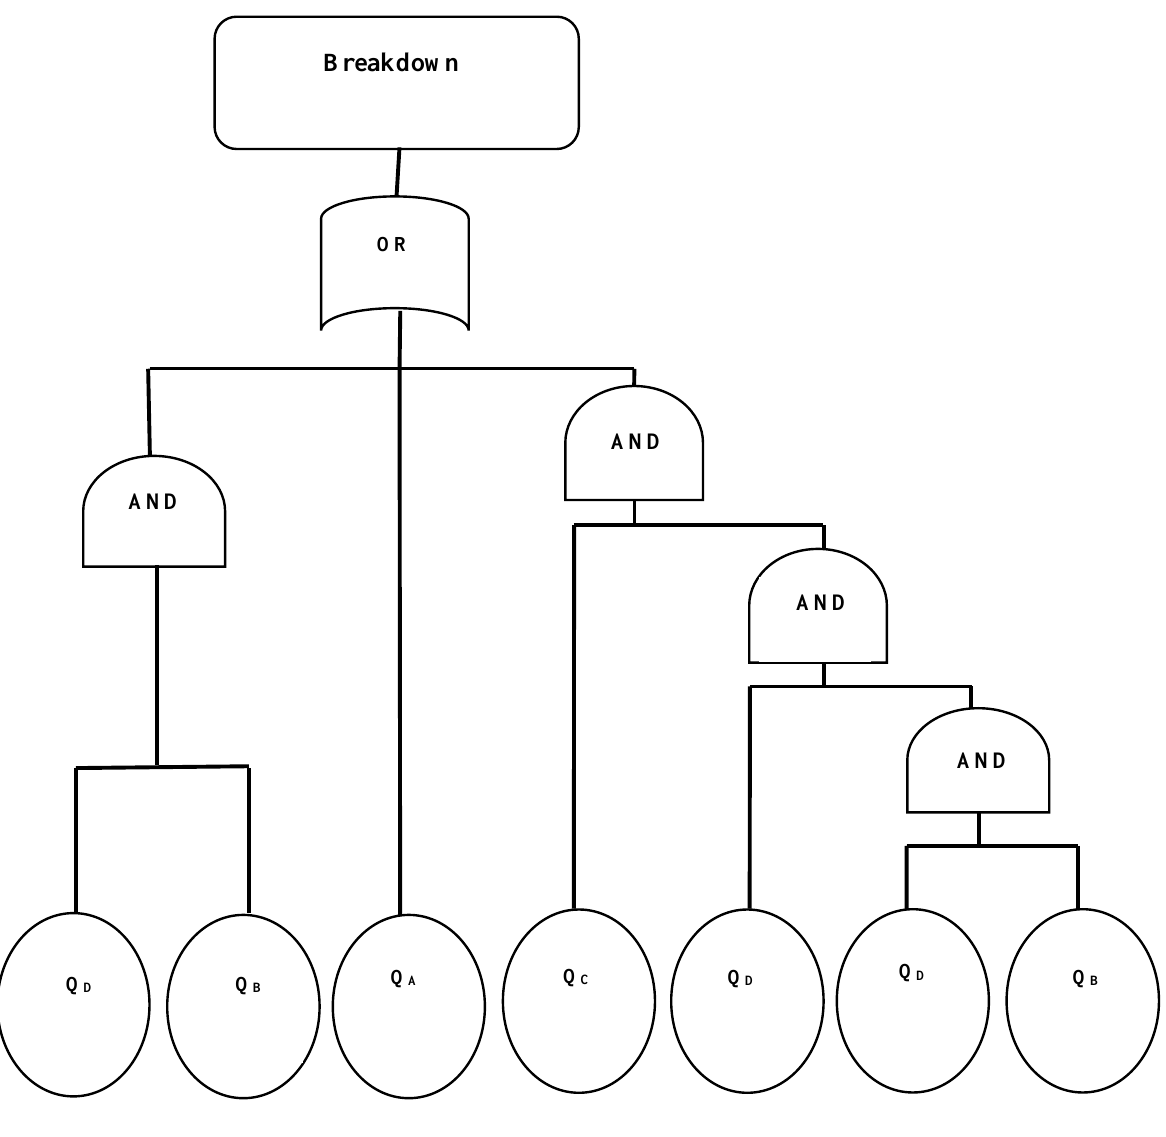
Figure 1. Fault tree analysis diagram for the Example derived from